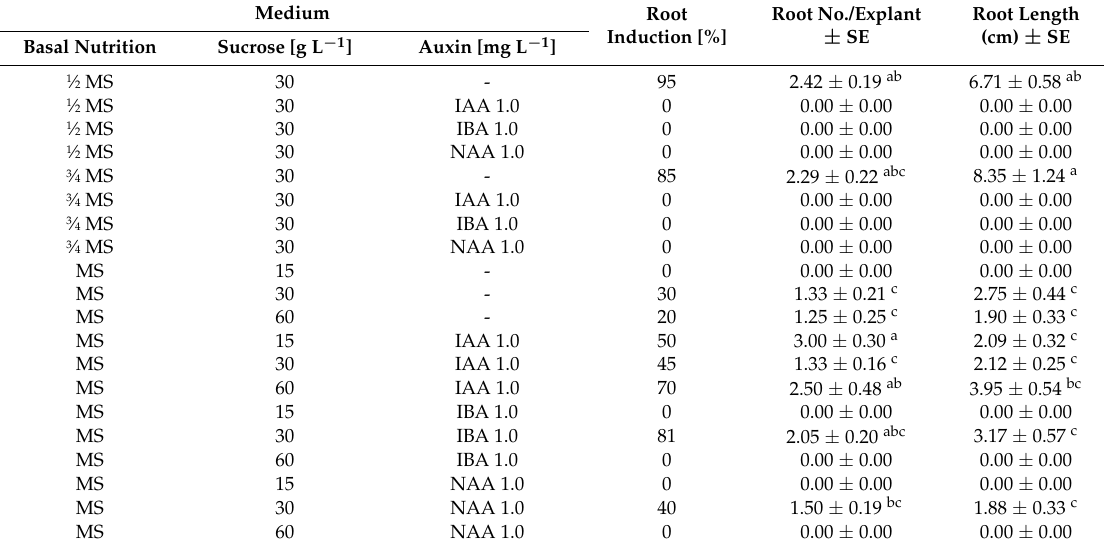
Table 2. Effect of medium salts, sugar concentration and auxins on rooting of Chaenomeles japonica shoots after six weeks of in vitro